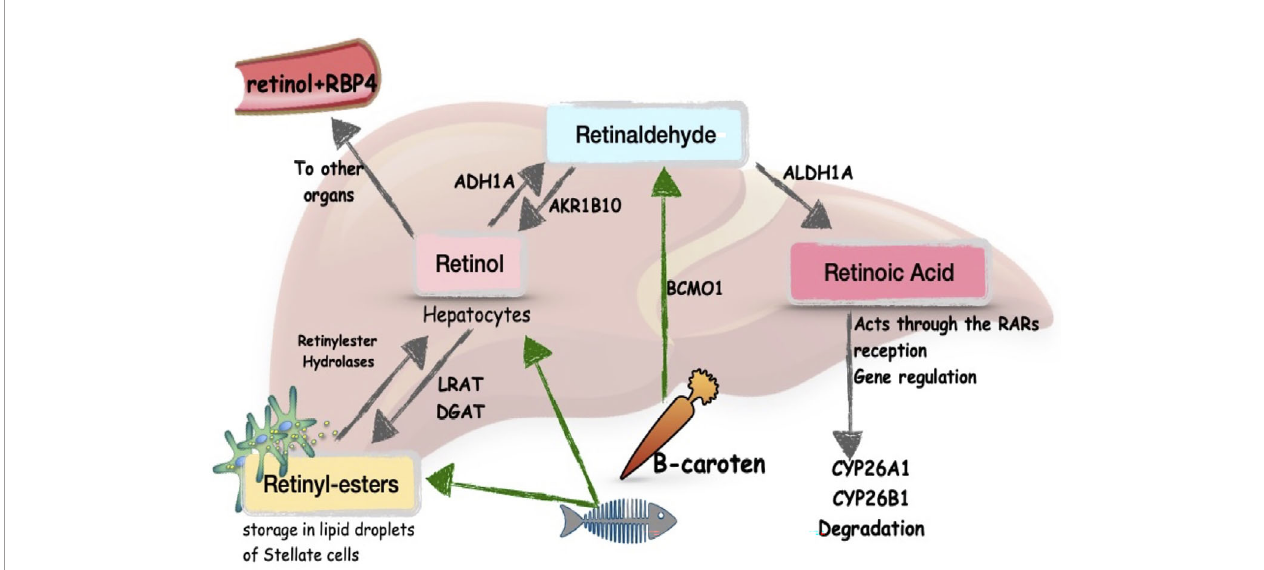
FIGURE 1 | Metabolism of vitamin A in the liver. Schema modi fi ed from Blaner, 43 and Pettinelli et al., 44. LRAT, lecithin retinol acyltransferase; DGAT, diglyceride acyltransferase; ADH1A, alcohol dehydrogenase 1A; AKR1B10, aldo-keto reductase family 1 member B10; BCMO1, beta-carotene monooxygenase; ALDH1A, aldehyde dehydrogenase 1 family member A; RBP4, retinol binding protein